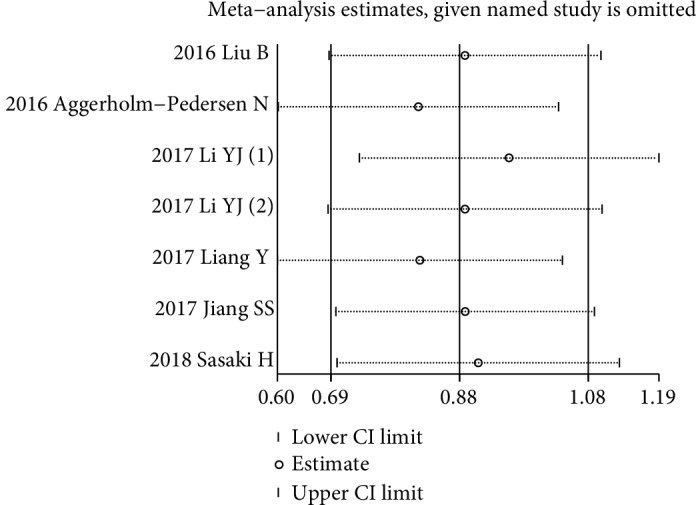
The plot of sensitivity analysis showing the influence of each one of the included study.